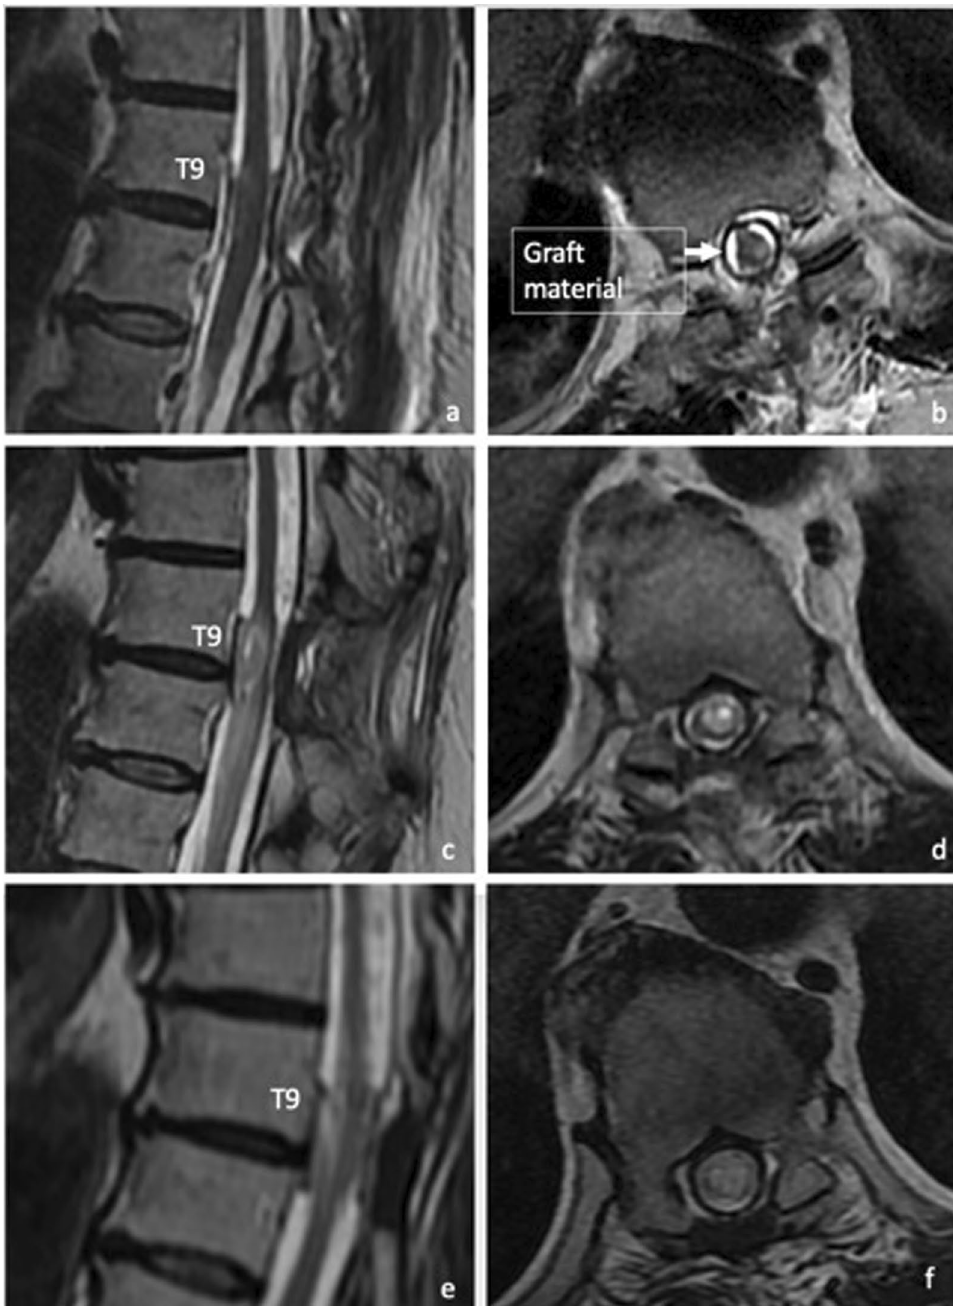
Fig. 2 Postoperative follow-up MRI scans of the thoracic spine. A , B Axial and sagittal T2-weighted MRI imaging of the surgical site. The spinal cord is reduced to its normal anatomical position, and the bovine pericardium graft was circumferentially covering the dural surface and the ventral dural defect. C , D Sagittal and axial T2-weighted MRI imaging of the follow-up MRI scan 2 months postoperatively showing contusion and myelomalacia in the spinal cord rostrally and caudally. E , F : Sagittal and axial T2-weighted MRI imaging of the follow-up MRI scan 8 months postoperatively. Images show remission of the contusion and myelomalacia. The patient’s neurologic status improved